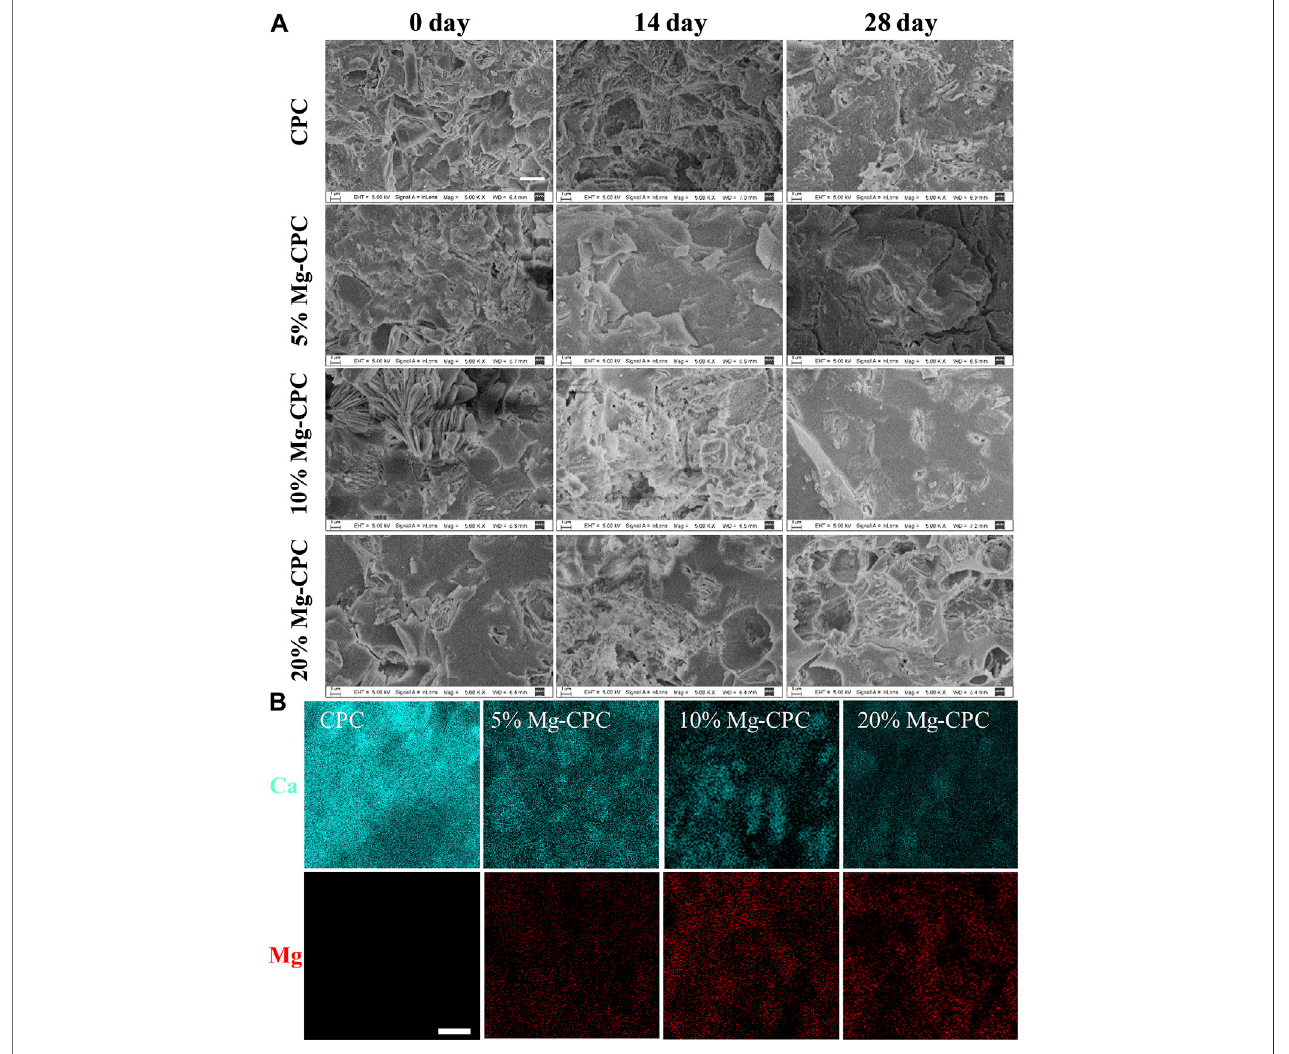
FIGURE1| SurfacemorphologyofCPCandMg-CPCssamplesbySEM. (A) TheSEMimagesofCPCandMg-CPCssamplesafterimmersioninSBF(Scalebar= 3 μ m). (B) EDS mapping of Ca (blue dots), Mg (red dots); EDS analysis elements ’ composition on cement surfaces after immersion in SBF (Scale bar = 10 μ m).